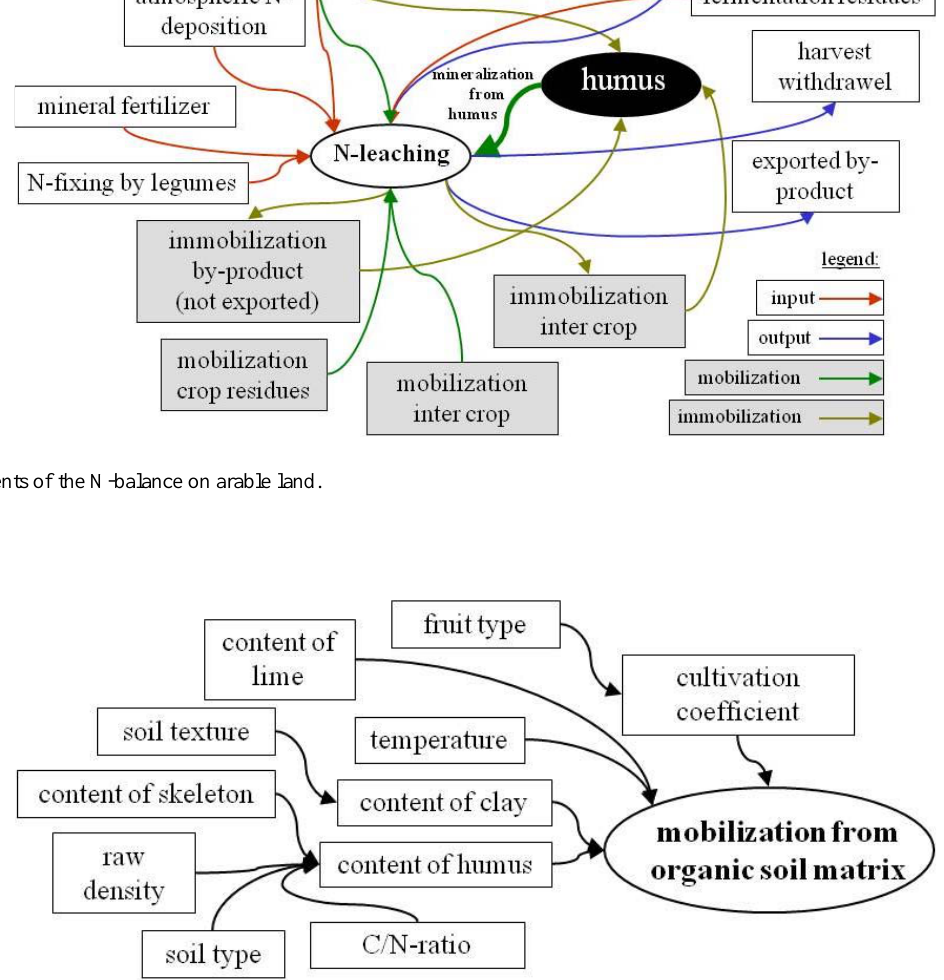
Fig. 3. Derivation of mineralization rates from the organic soil matrix on arable land.